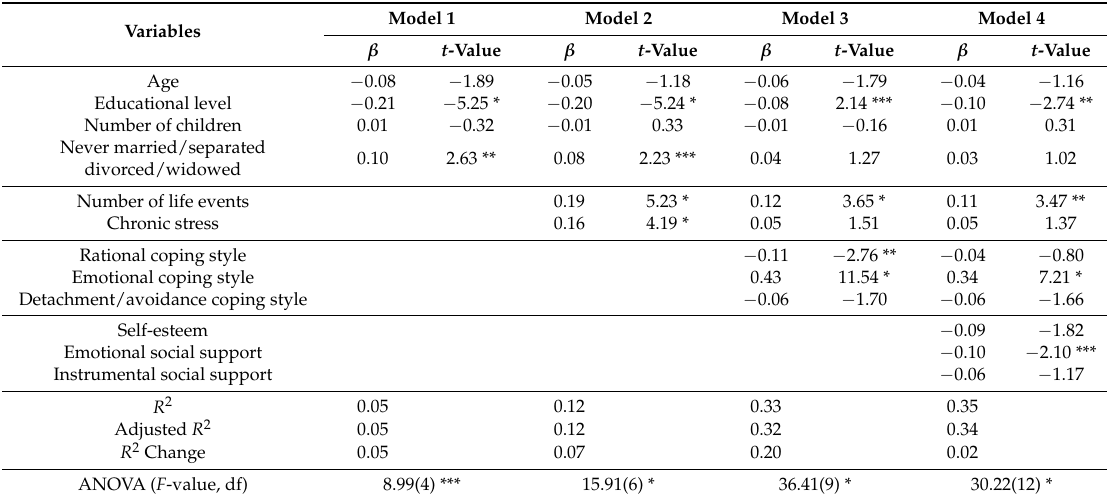
Table 4. Summary of the hierarchical regression with psychological distress as the dependent variable for the women